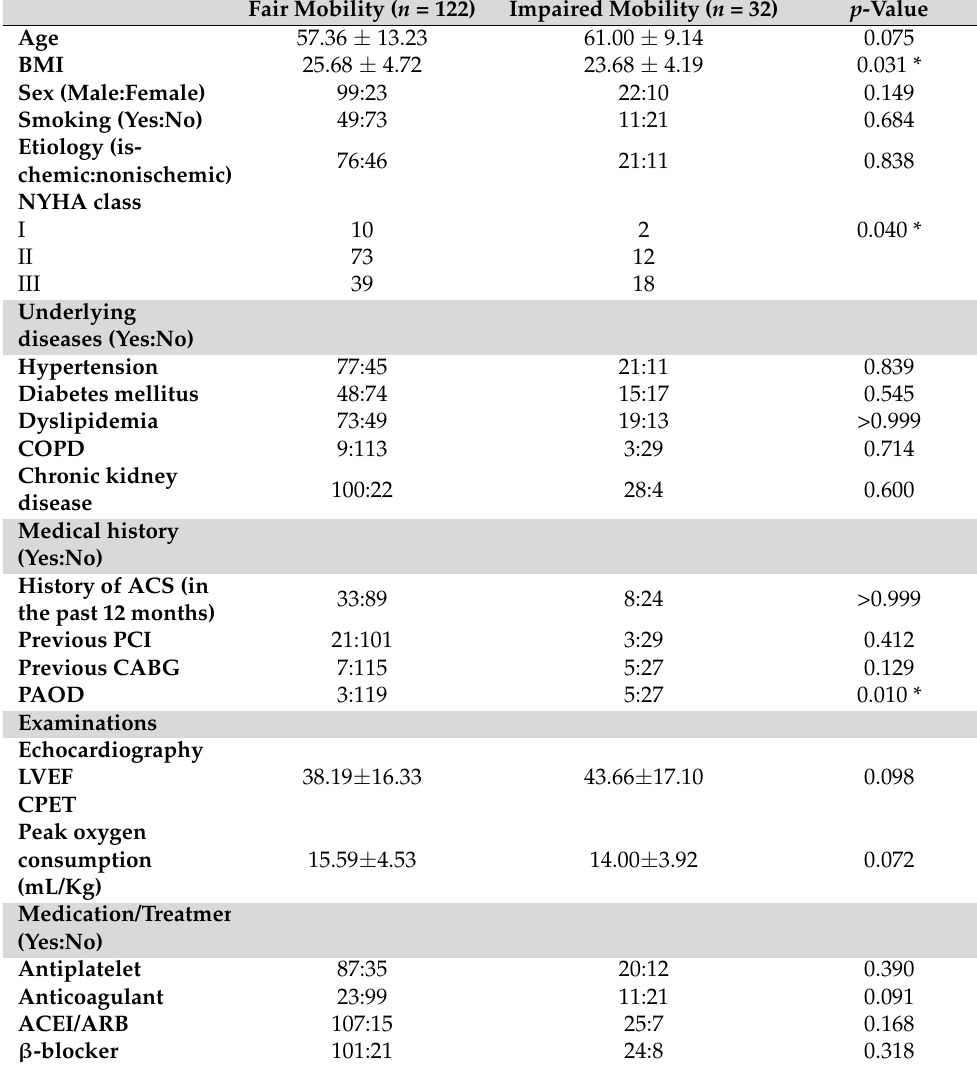
Table 1. Baseline characteristics of the